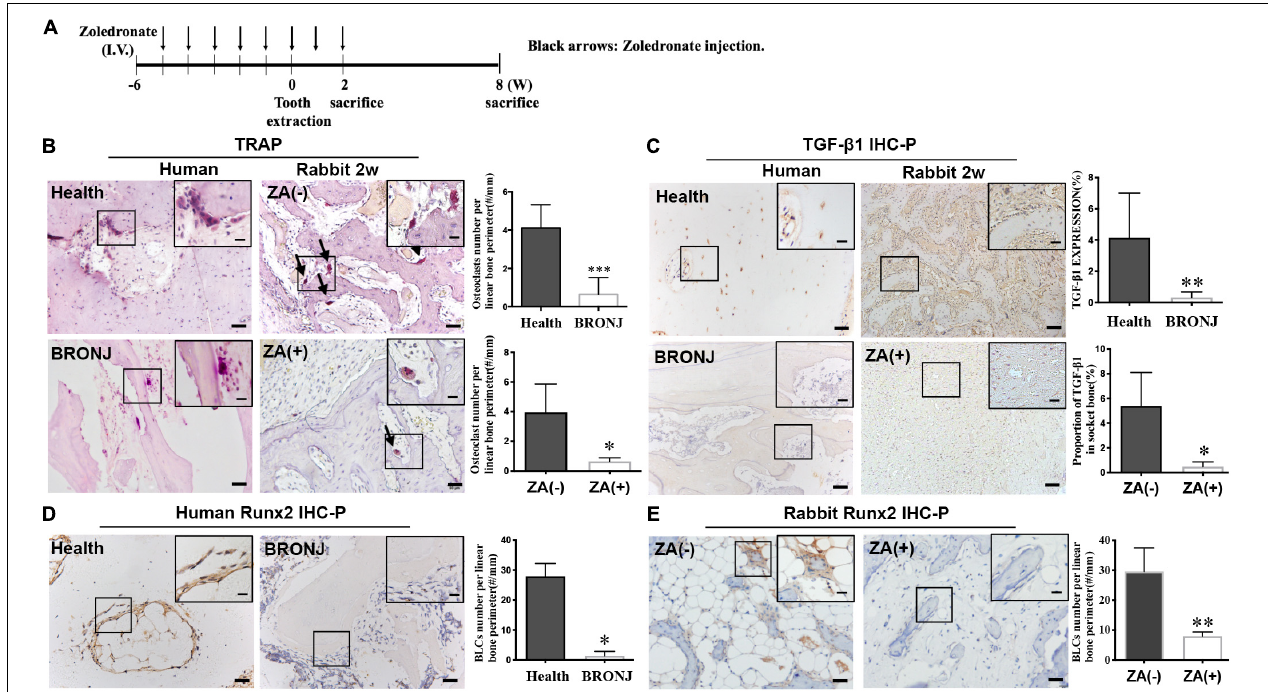
FIGURE 1 | TGF- β 1 and bone remodeling cells are decreased in BRONJ patients and an animal model. (A) Schematic diagram of inducing a BRONJ-like rabbit model. Rabbits were i.v. injected with zoledronate (800 µ g/kg, black arrows) 6 weeks before tooth extraction followed by zoledronate injection for 2 weeks. (B) TRAP staining of osteoclast images in the jaws of BRONJ patients and healthy donors. TRAP staining of osteoclasts after 2 weeks after the surgical tooth extraction in BRONJ-like animals from zoledronic acid-untreated [ZA(–)] and zoledronic acid-treated [ZA(+)] groups. Insets show magnified boxed region. The graphs indicate the quantification of TRAP-positive cells in humans and rabbits. Black arrows show osteoclasts. (C) Images of TGF- β 1 IHC staining and quantifying its expression in human and rabbit jaws 2 weeks after tooth extraction. (D) IHC of Runx2-positive BLCs and quantification in BRONJ patients and healthy donors. (E) IHC of Runx2 images and quantifications in rabbits in ZA(–) and ZA(+) groups. (All bars: 50 µ m; bar of magnified images: 20 µ m). ∗ p < 0.05, ∗∗ p < 0.01, ∗∗∗ p < 0.005.